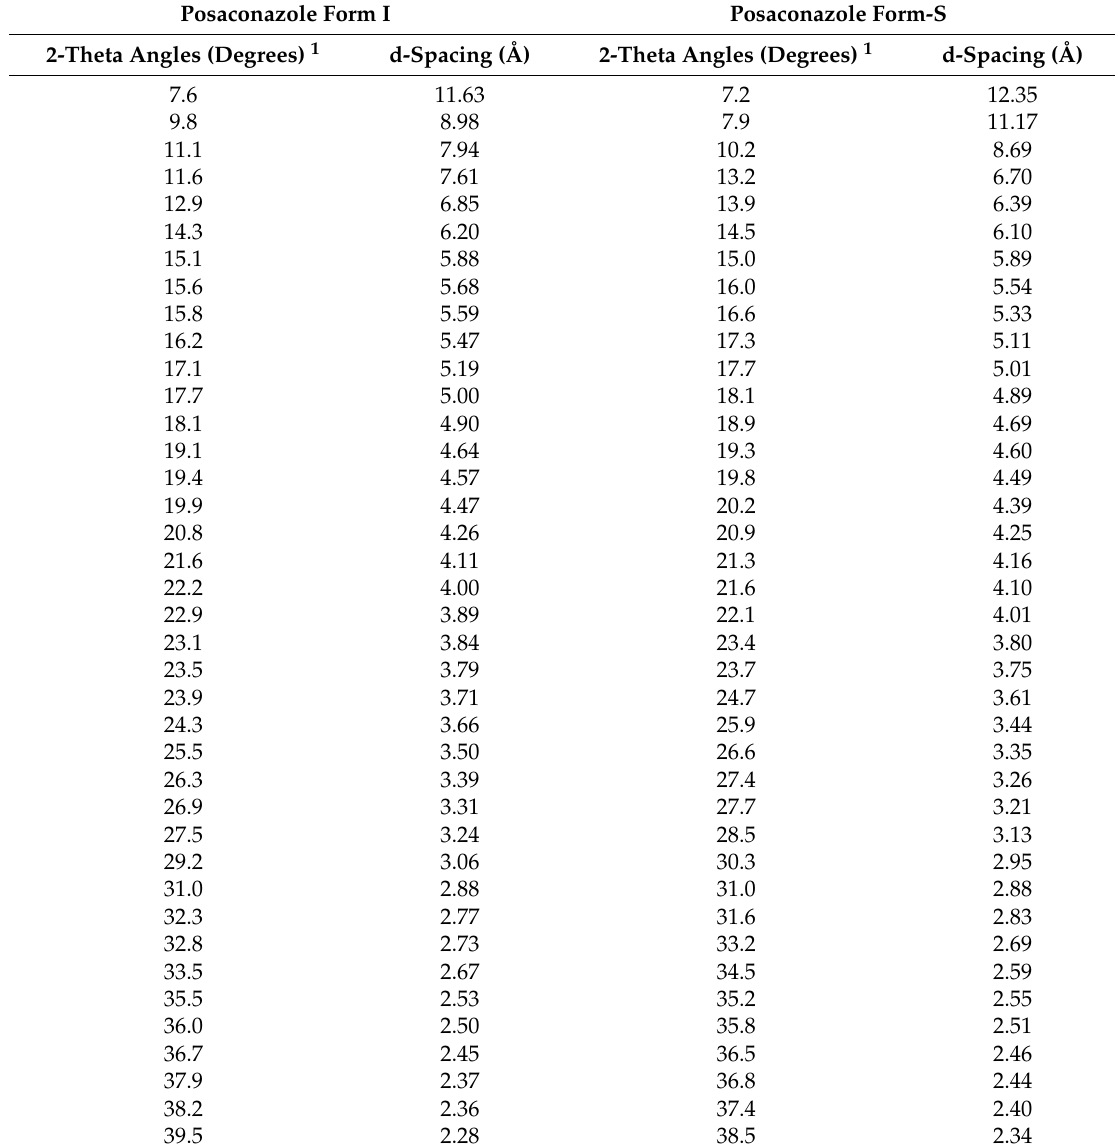
Table 1. The characteristic 2-theta di ff raction angles and d-spacing of the XRPD patterns of Posaconazole Form I and Posaconazole